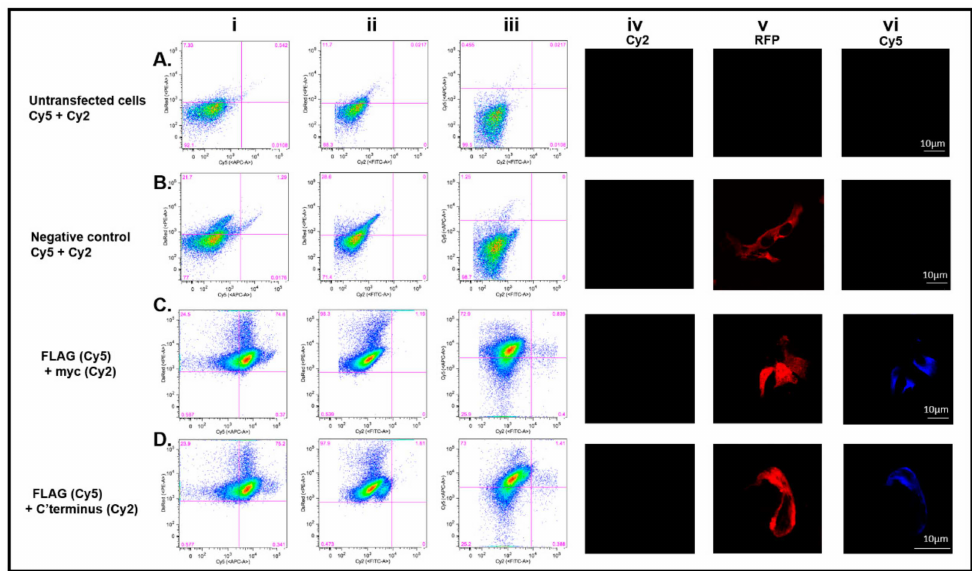
Figure 6. Validation of DDX4 C-terminus antibody specificity using a cluster of di ff erentiation 2 (CD2) transmembrane protein construct. Intact, single cells were gated before analysis and sorting.